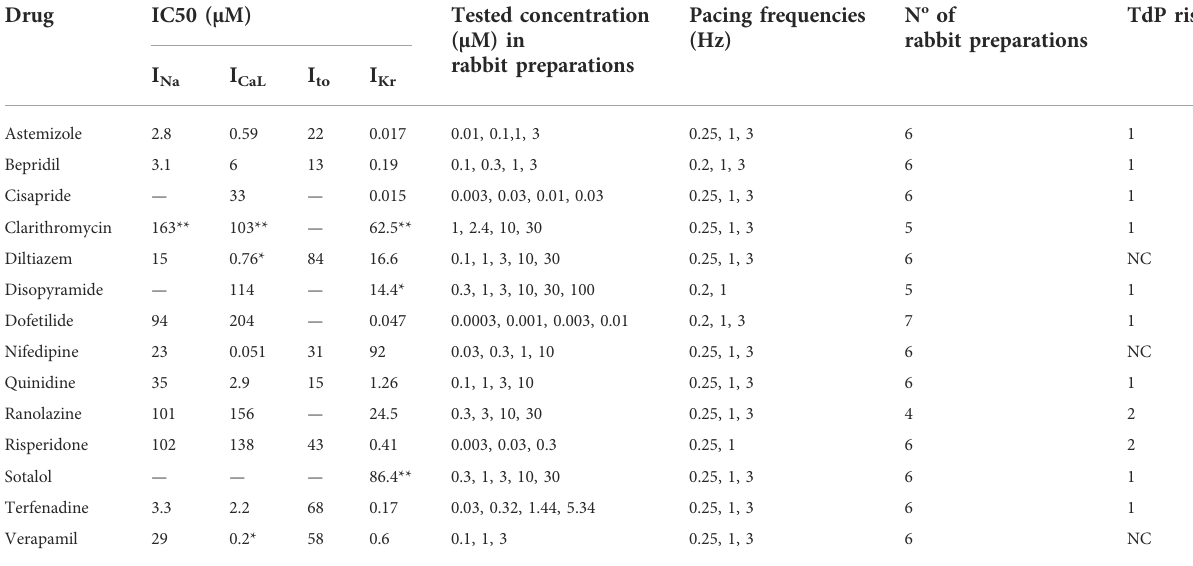
TABLE 1List of reference compounds, IC50 valuesrecordedfor four ioniccurrents,tested concentrationsin rabbit preparations,pacing frequencies, N o of preparation used, and clinical proarrhythmic risk as reported by CredibleMeds ® (Woosley and Romer, 1999). Drug IC50 (µM) Tested concentration